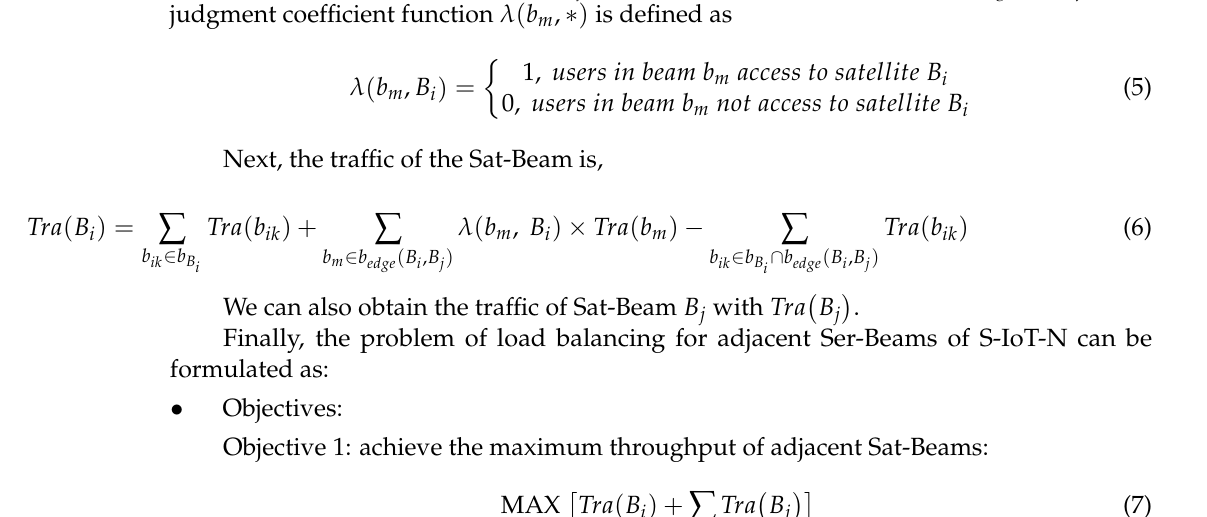
The Ser-Beams of B i